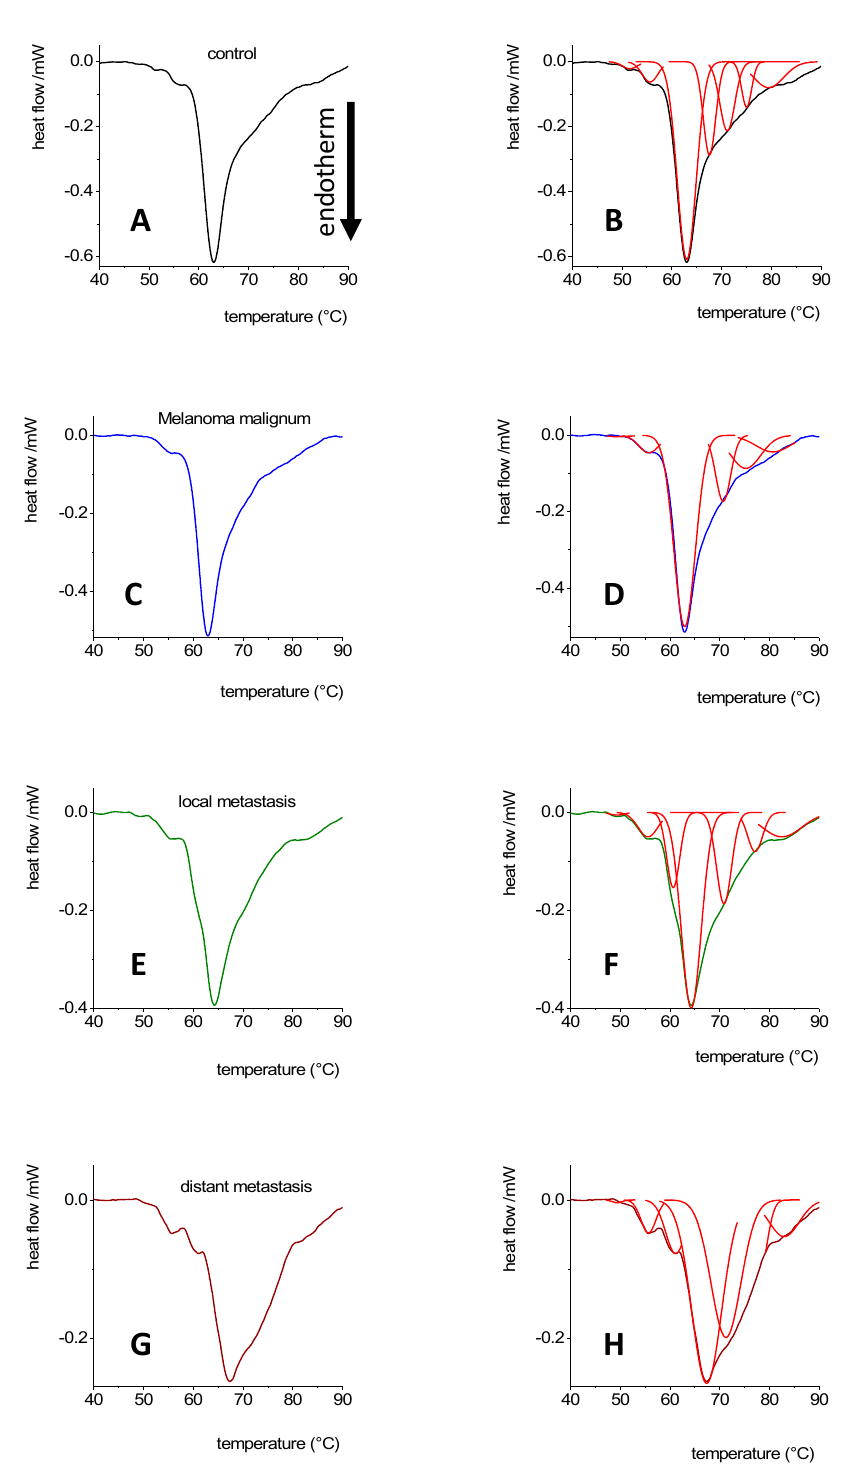
Figure 4. DSC curves [34,35] and their deconvolution in case of blood plasma from control ( A , B ), melanoma malignum ( C , D ), local metastasis ( E , F ) and distant metastasis ( G , H ). The number of healthy control patients was n = 5 and from patients afflicted with different stage of melanoma n = 15.